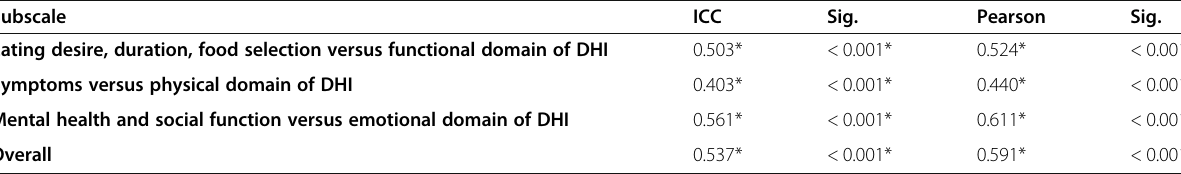
Table 4 ASWAL-QOL verses and DHI Subscale ICC Sig. Pearson Sig. Eating desire, duration, food selection versus functional domain of